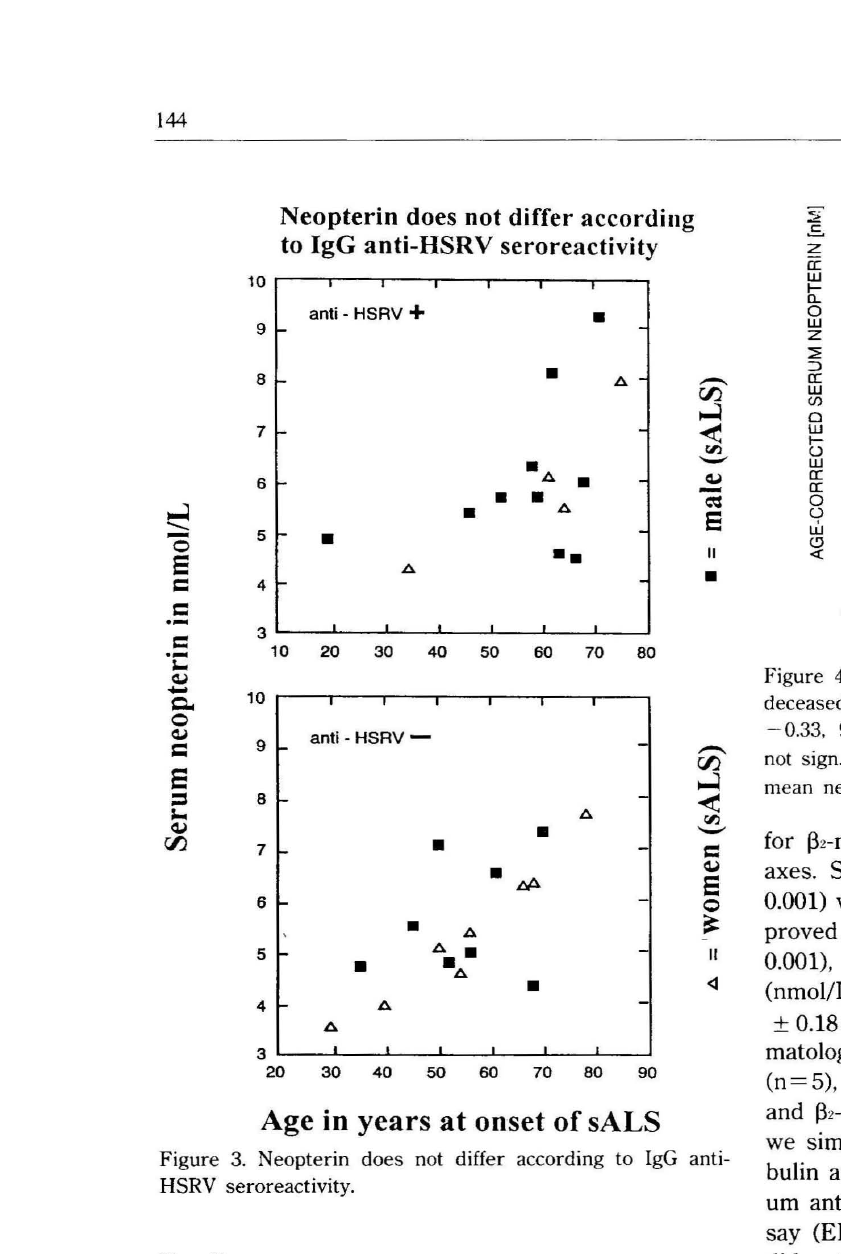
Figure 3. Neopterin does not differ according to IgG anti HSRV seroreactivity.